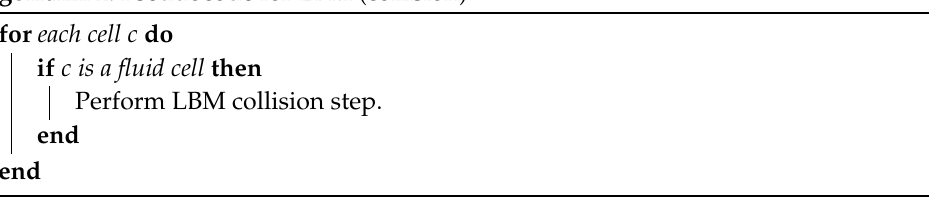
Algorithm 3: Pseudocode for LBM